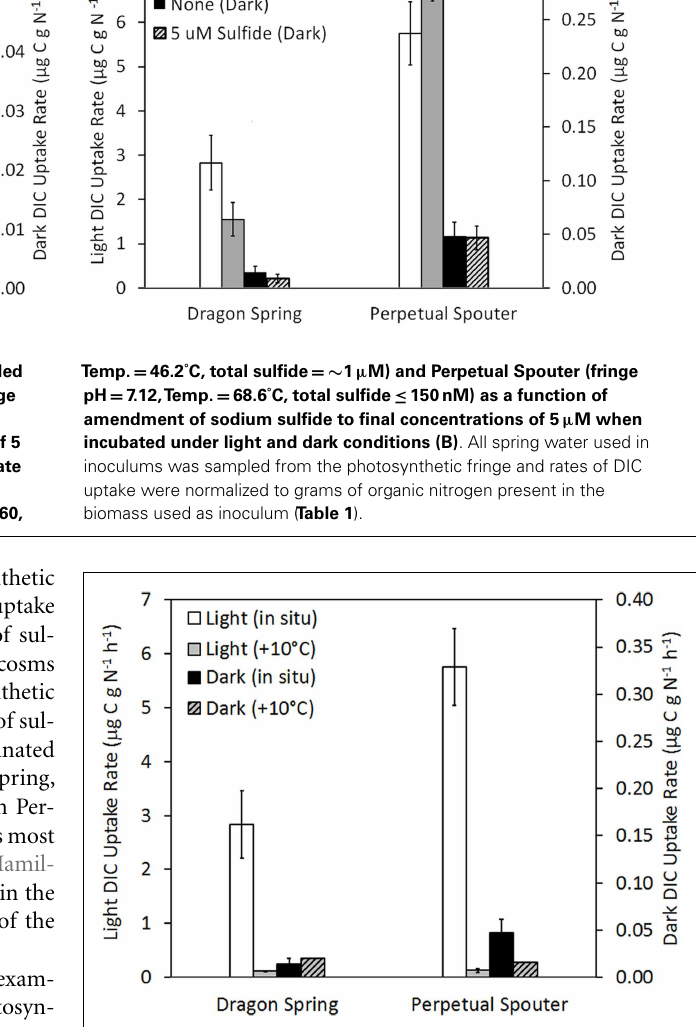
FIGURE 6 | Rate of DIC uptake in phototrophic assemblages sampled from near the photosynthetic fringe at Dragon Spring (fringe pH = 2.60, Temp. = 46.2˚C, total sulfide = ∼ 1 µ M) and Perpetual Spouter (fringe pH = 7.12,Temp. = 68.6˚C, total sulfide ≤ 150nM) when incubated at the fringe temperature as well as at a temperature ∼ 10˚C greater than at the fringe temperature (58.0 and 78.4˚C, respectively), under both light and dark conditions. All spring water used in microcosms was sampled from near the photosynthetic fringe and rates of DIC uptake were normalized to grams organic nitrogen in biomass that served as inoculum ( Table 1